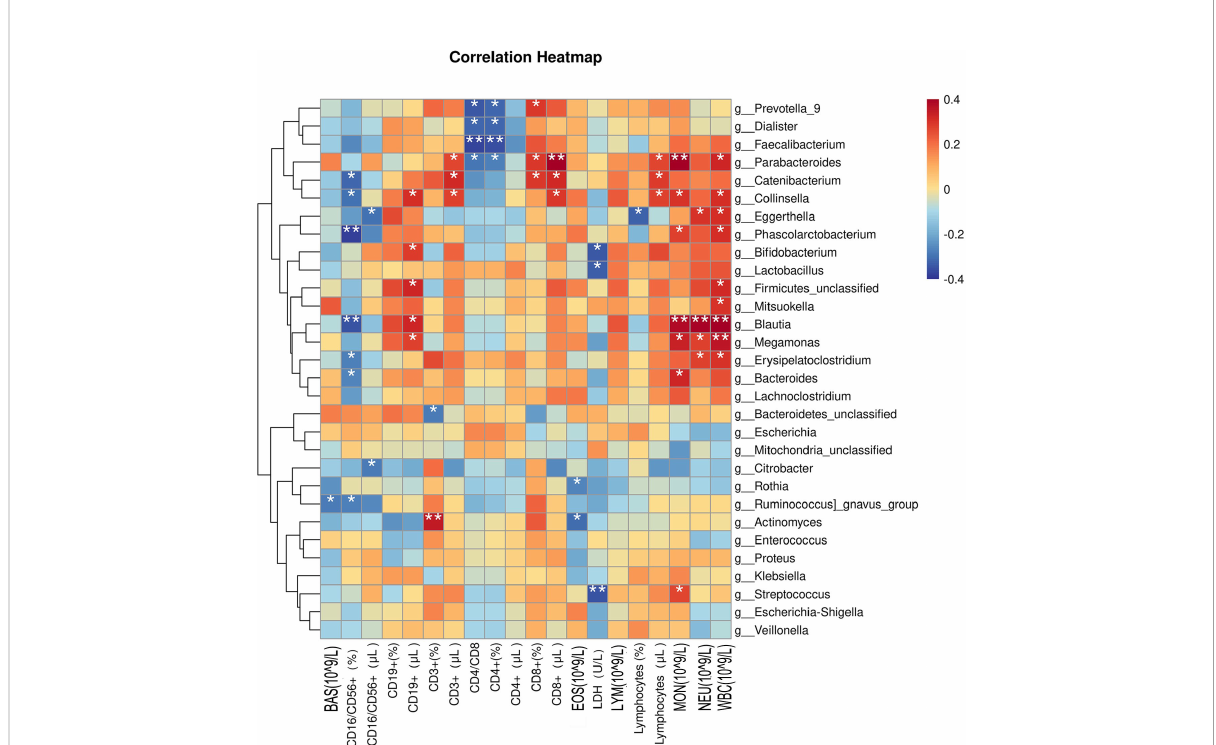
FIGURE 7 Correlations between clinical indicators and the top 30 microorganisms in the intestinal fl ora. BAS, basophil; CD, cluster of differentiation; EOS, eosinophil; LDH, lactic dehydrogenase; LYM, lymphocyte; MON, mononuclear cell; NEU, neutrophil; WBC, white blood cell. *p < 0.05 and ** p < 0.01 were considered statistically signi fi